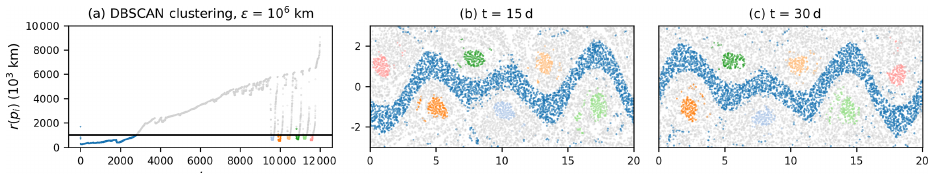
Figure 4. Result of DBSCAN clustering of the 2D embedding of the classical MDS method. (a) Reachability plot, with the black line representing the DBSCAN parameter (cid:15) . (b–c) Corresponding clustering results at different times. Grey particles represent noise. Axis units are in 1000km.